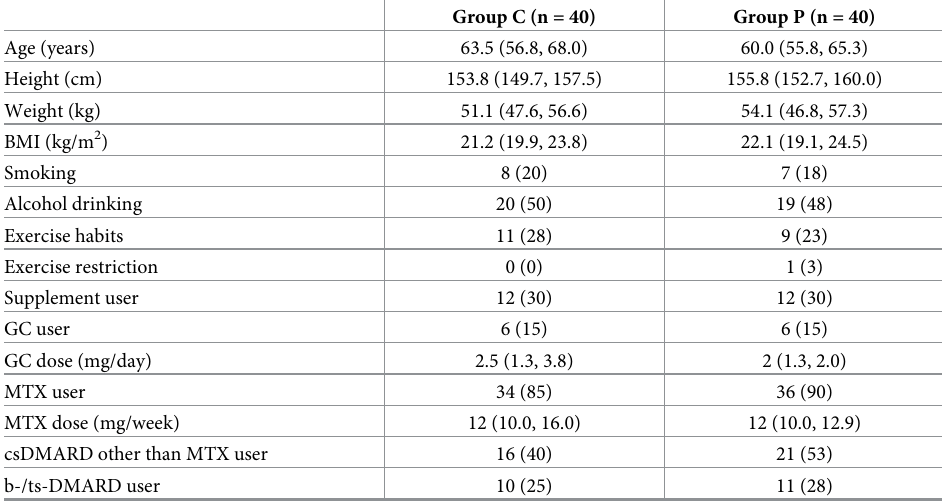
Fig 1. Study flowchart. FAS, full analysis set; PPS, per protocol set; SAS, safety analysis set. https://doi.org/10.1371/journal.pone.0252357.g001 Baseline and demographic characteristics Demographic and baseline characteristics are presented in Table 1. The median and interquar- tile range of age of the overall study cohort was 61.5 (56.0, 67.3) years. Table 1. Demographic and baseline characteristics of